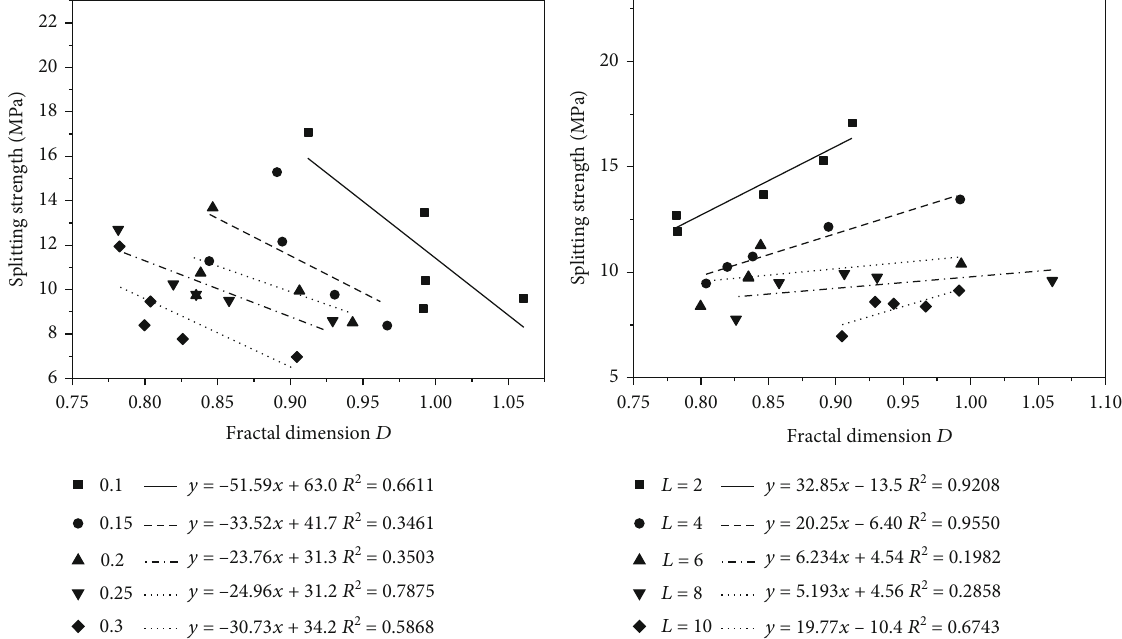
Figure 11: Relationship between fracture fractal and specimen strength under di ff erent fabric parameters.